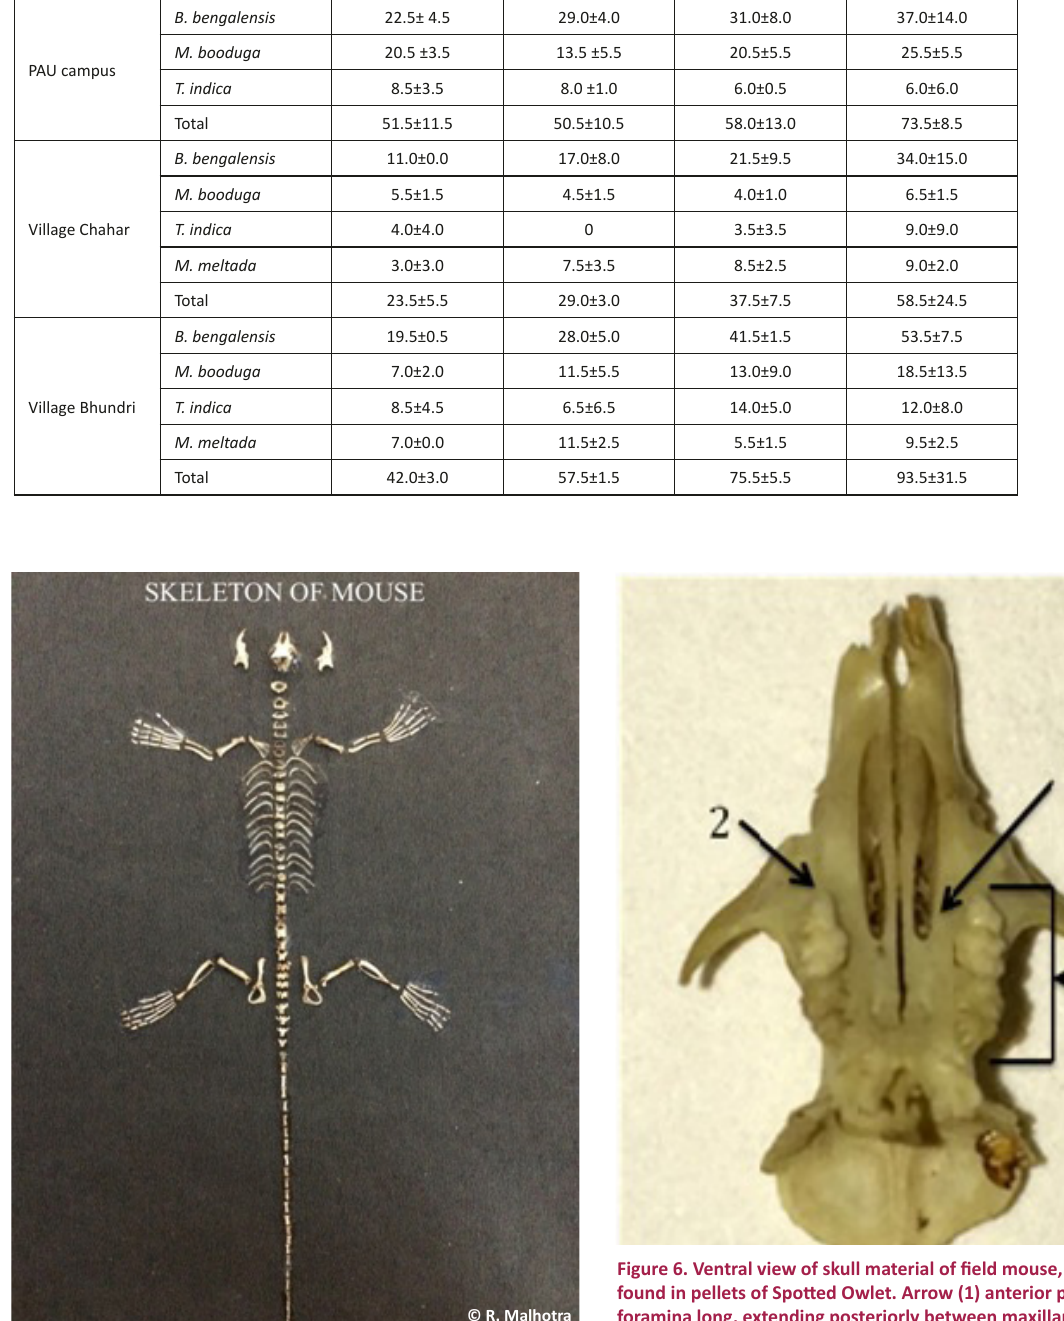
Table 3. Live rodent burrow count around roosting and nesting sites of Spotted Owlets. Location